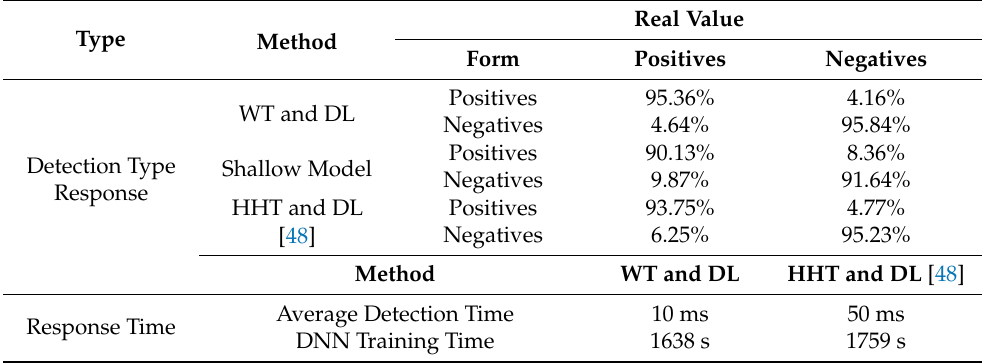
Table 4. The value matrix of the presented detection